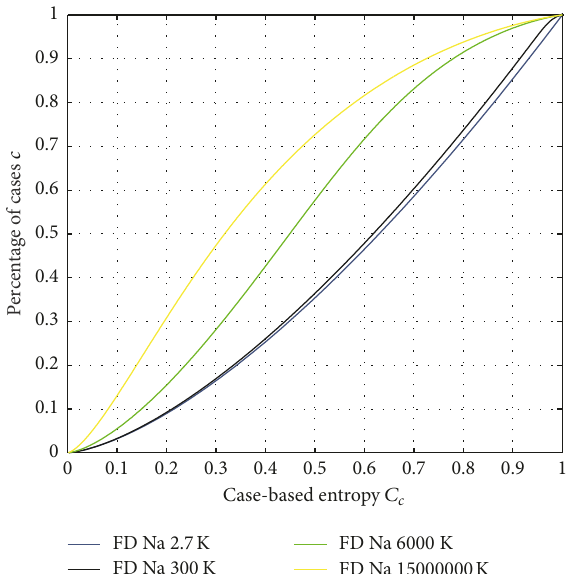
Figure 4: Diversity curves for sodium electrons at a range of temperatures with 𝐶 𝑐 on the 𝑥 -axis and 𝑐 on the 𝑦